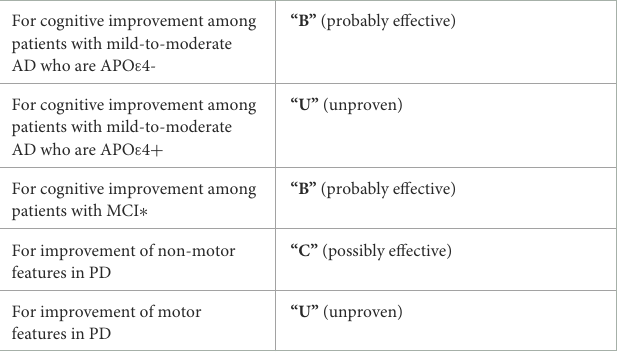
TABLE 2 Collective strength of evidence to date (per AAN criteria): ketogenic interventions in AD, MCI, and PD. For cognitive improvement among patients with mild-to-moderate AD who are APO ε